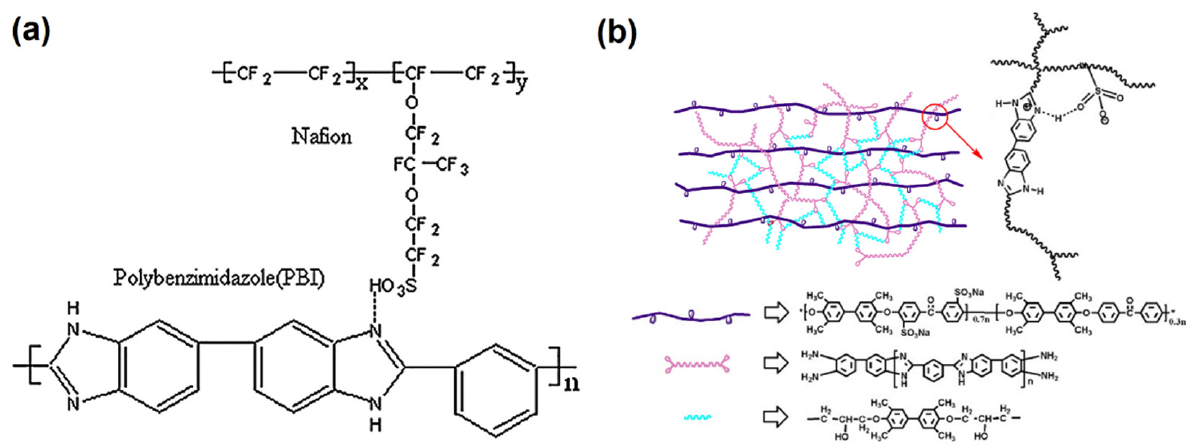
Figure 7. ( a ) The formation mechanism between the sulfonic acid group of Nafion and the imidazole nitrogen of PBI from Ref. [127]; ( b )Schematic representation of the SPEEK/o-PBI/TMBP composite membranes from Ref. [125].